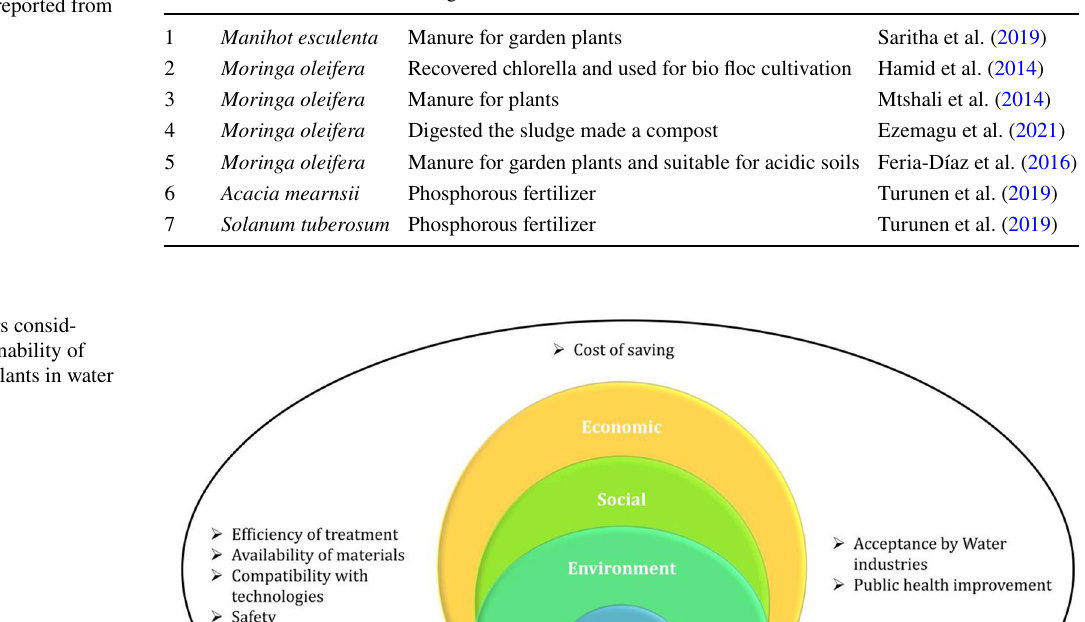
after coagulation reported from the literature